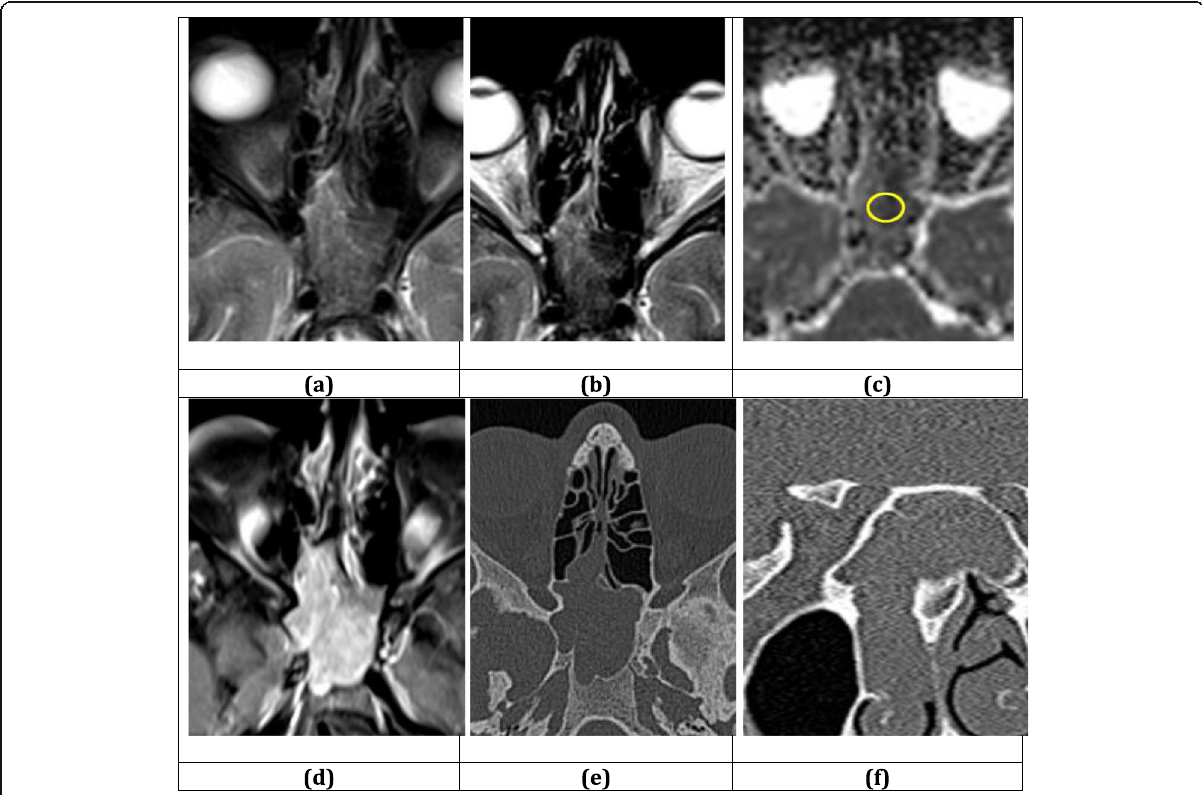
Fig. 7 A 37-year-old female with proven sphenoid sinus inverted papilloma. Axial T2-weighted ( a ) shows the solid tissue filling the sinus, with faintly depicted curved striations in multiple opposed direction, more resolved in axial non-FAT saturation T2-weighted image ( b ). Apparent diffusion co-efficient map ( c ) reflects the compact cellularity with a small apparent diffusion co-efficient value of 0.7 × 10 -3 cm 2 /s. Axial post- gadolinium-enhanced image ( d ) reveals solid enhancing mass with very ill-defined striations. Axial computed tomography image ( e ) reveals non- specific opacity. Coronal computed tomography image ( f ) reveals lobulated sphenoid sinus opacity pedunculated through spheno-ethmoidal recess showing smooth